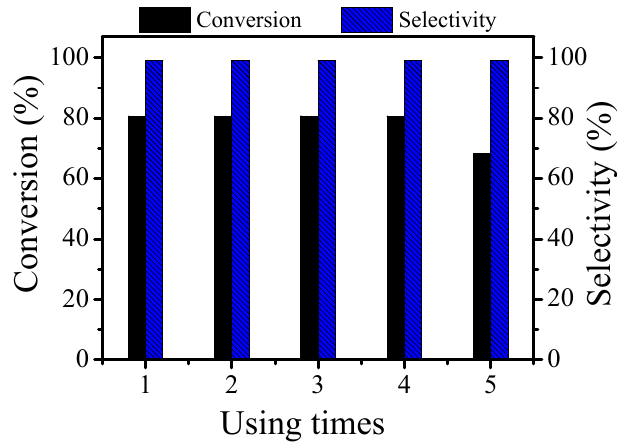
Figure 10. The recycling ability test of 4 wt % Pt/ γ -Bi 2 MoO 6 on the reaction of benzyl alcohol and acetophenone.